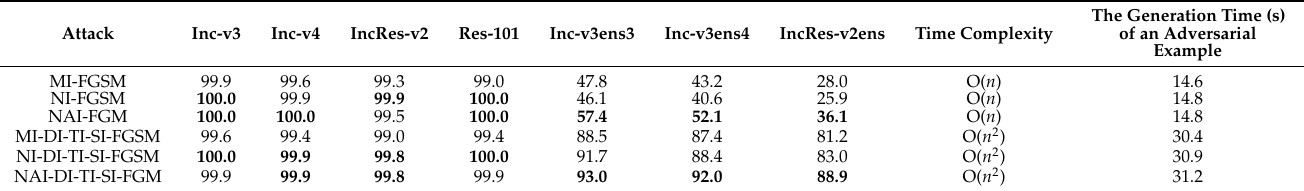
Table 5. Comparison of the success rates (%) of various advanced momentum-based iterative attacks when attacking an ensemble of models. The bolded data indicates the highest success rate for the same type of